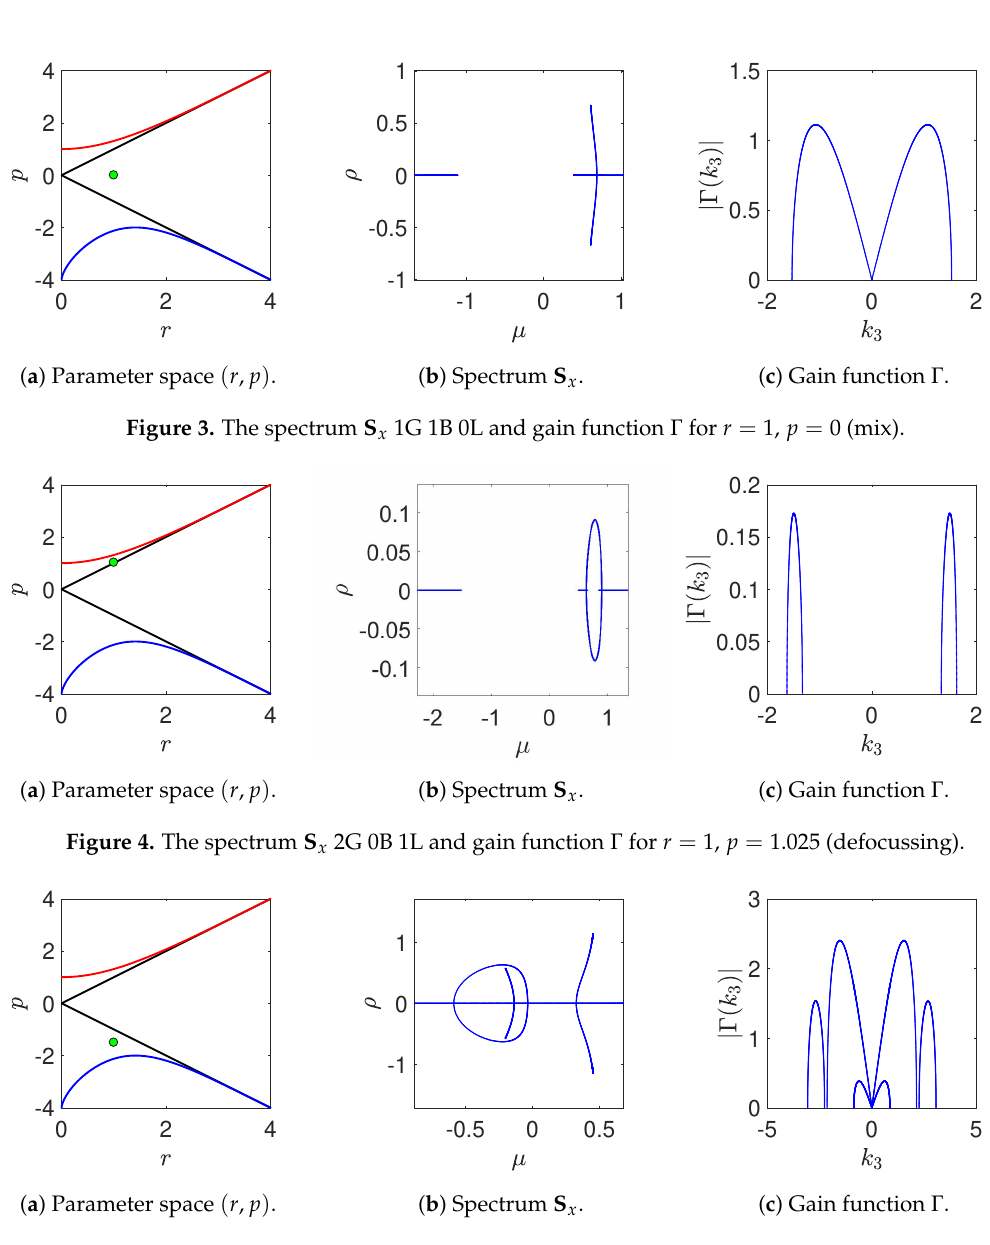
Figure 5. The spectrum S x 0G 2B 1L and gain function Γ for r = 1, p = − 1.5 (focussing).